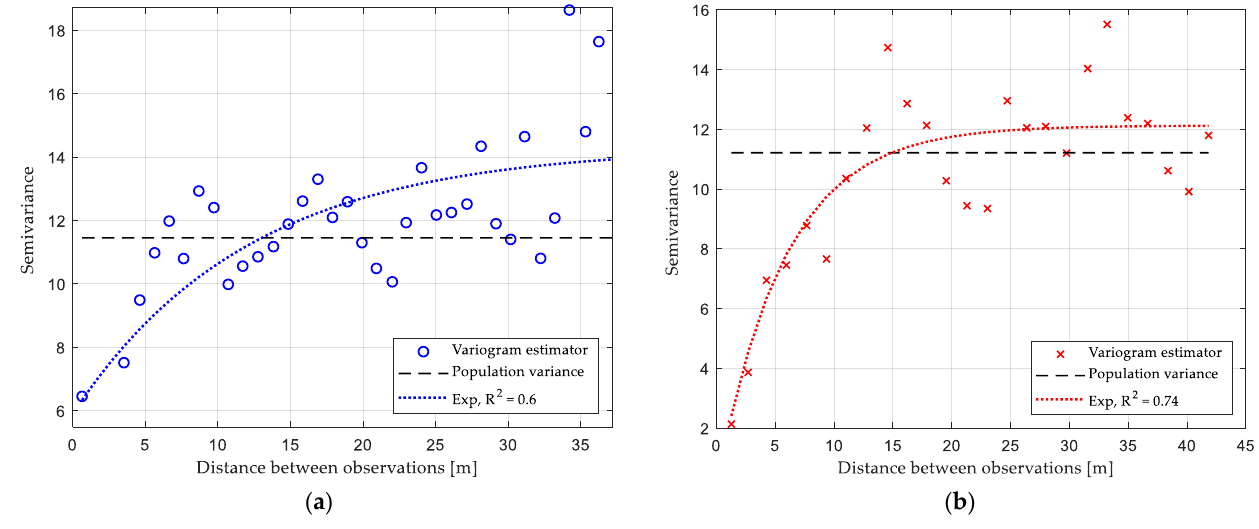
Figure 6. Variography results. ( a ) SS UDP & USM O2I link. ( b ) OS UDP & USM O2I link.